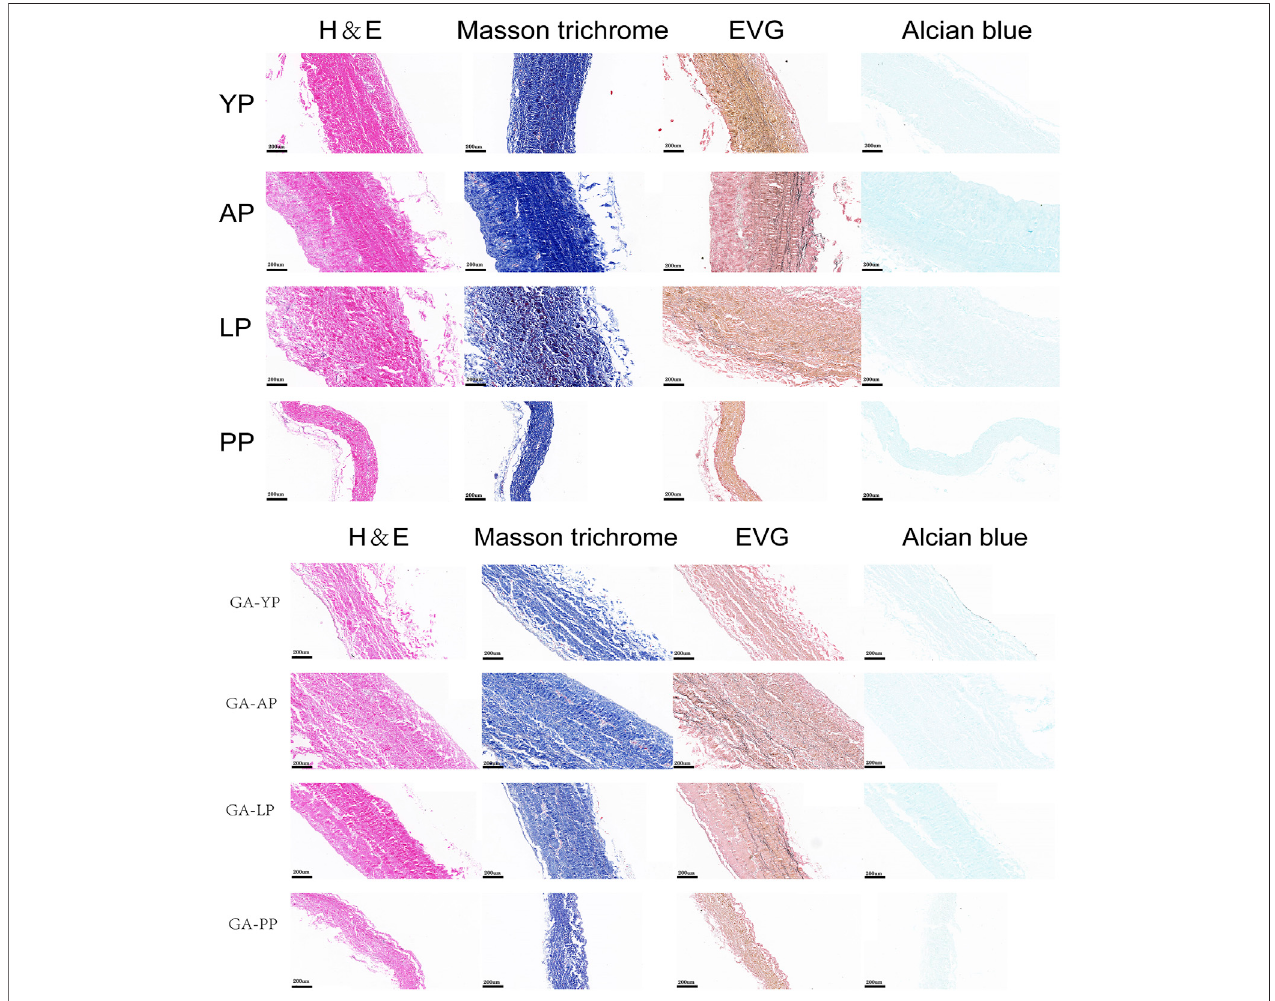
FIGURE1| HEstaining,MASSONstaining,EVGstaining,andAlcianbluestainingforECMevaluationoffreshyakpericardium,freshAustralianbovinepericardium, fresh local bovine pericardium, fresh porcine pericardium ,GA-crosslinked yak pericardium, GA-crosslinked Australian bovine pericardium, GA-crosslinked local bovine pericardium, and GA-crosslinked porcine pericardium.scale bars are 200 um.